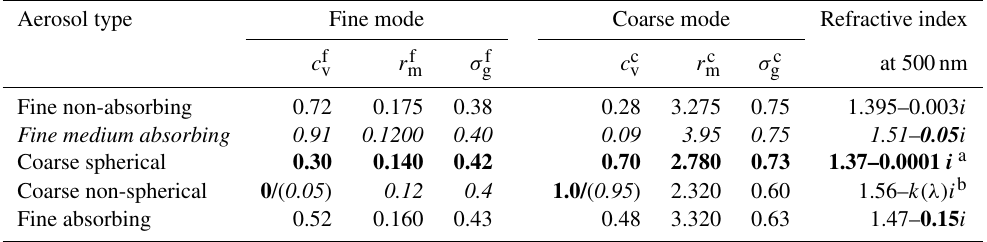
Table 5. Particle volume concentrations ( c v ), modal radii ( r m ), geometric standard deviation ( σ g ) of bi-modal lognormal size distributions and refractive indices at 500nm (adopted with modifications from Dubovik et al. (2002) and Smirnov et al. (2002), with modifications shown in bold); components that were not used in this study are presented in